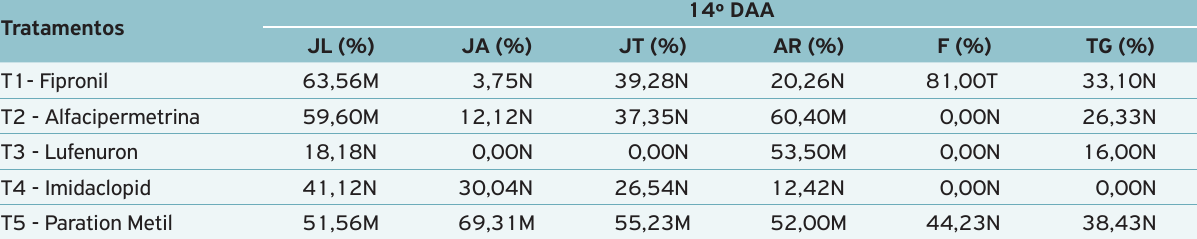
Tabela 4. Porcentagem (%) de redução das populações de larvas, adultos e total de joaninhas, aranhas e formigas coletados na cultura do algodão, no décimo quarto dia após a aplicação (DAA) de inseticidas. Malhada (BA), 2011.